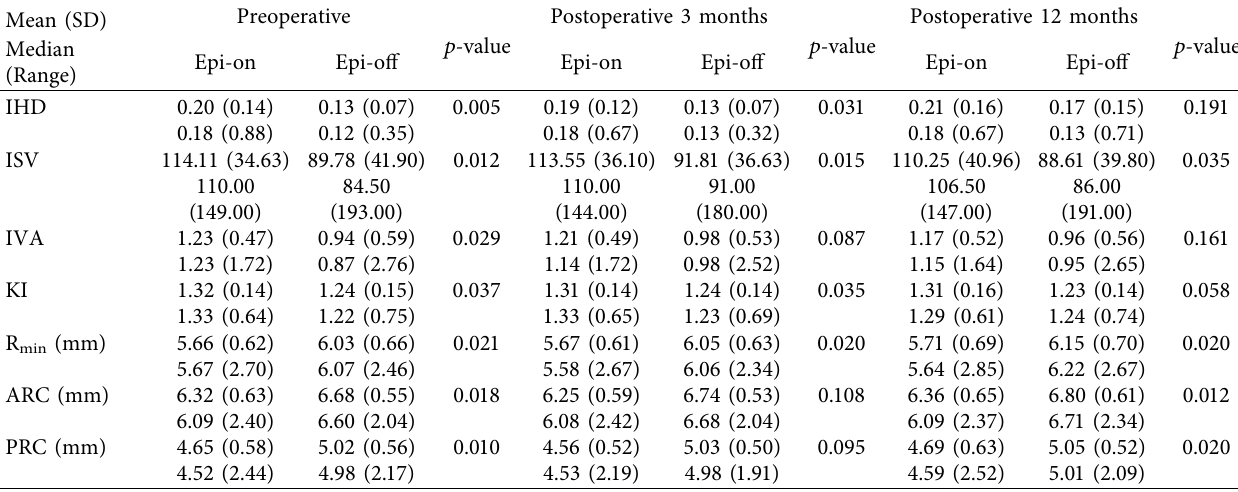
Table 4: Differences between the epi-on and epi-off groups in the corneal topometric parameters in the different visits of the follow-up. Mean